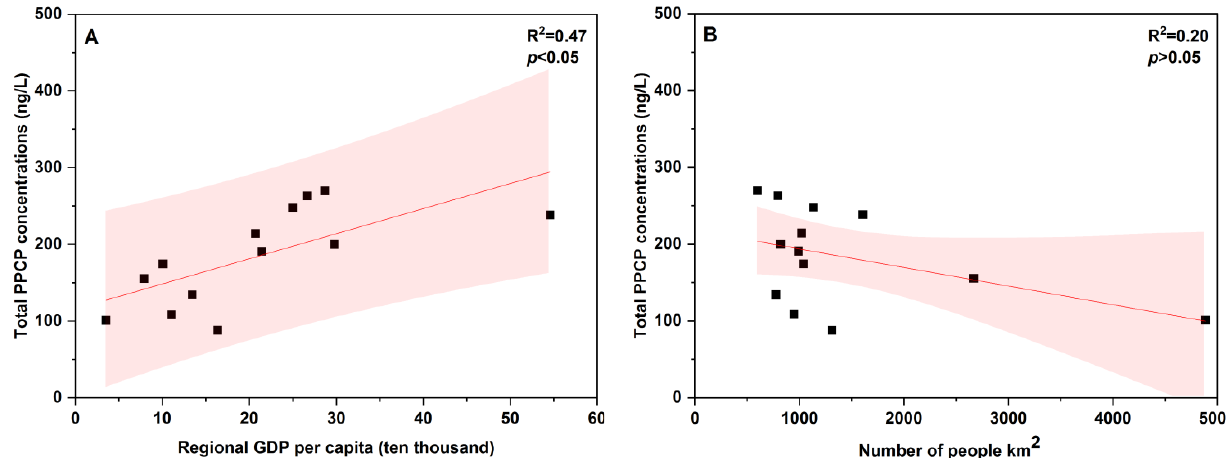
Figure 4. Relationship between concentrations of PPCPs and ( A ) GDP and ( B ) population density in the TLB. Note: the shaded area denotes 95% prediction interval, and the demographic and economic data were obtained from the latest official statistical yearbook; per capita GDP was calculated from resident population.